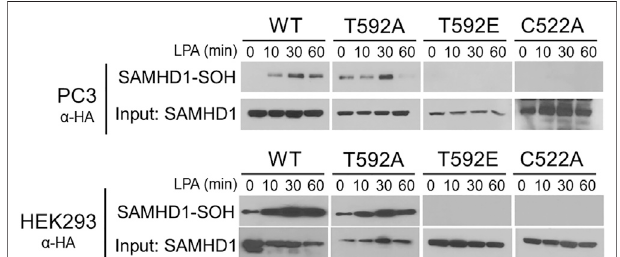
FIGURE 2 | SAMHD1 T592E is not oxidized in cells. PC3 and HEK293 cells expressing HA-SAMHD1 were treated with the growth factor, LPA, over time and harvested in the presence of DCP-Bio1 to capture proteins with cysteine sulfenic acids. Western blots of pulldowns probed with α -HA antibodies show oxidized SAMHD1 in cells expressing wild-type or T592A variant. No oxidized SAMHD1 appears in cells expressing the T952E or oxidation insensitive C522A